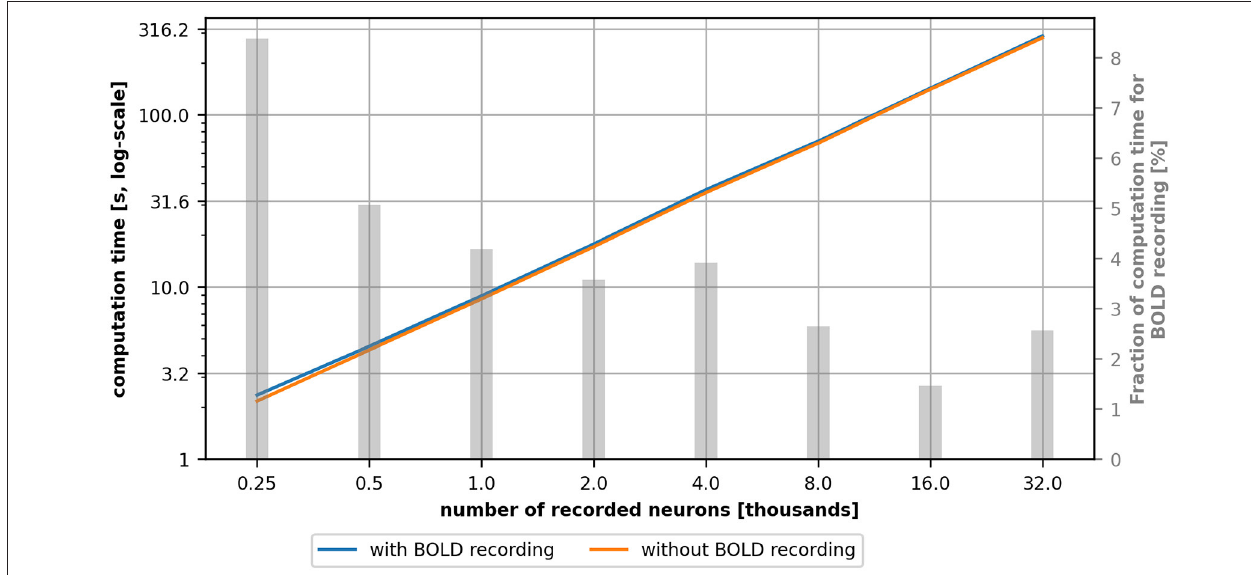
FIGURE 8 | Computational time for a simulation with (blue) and without (orange) BOLD recording as a function of the number of recorded neurons. The gray bars indicate the percentage of the computational overhead of the BOLD recording in the total computation time. This value was computed on the average values and therefore no standard deviation is depicted. The computational overhead is higher for small network models and gets smaller for larger models.